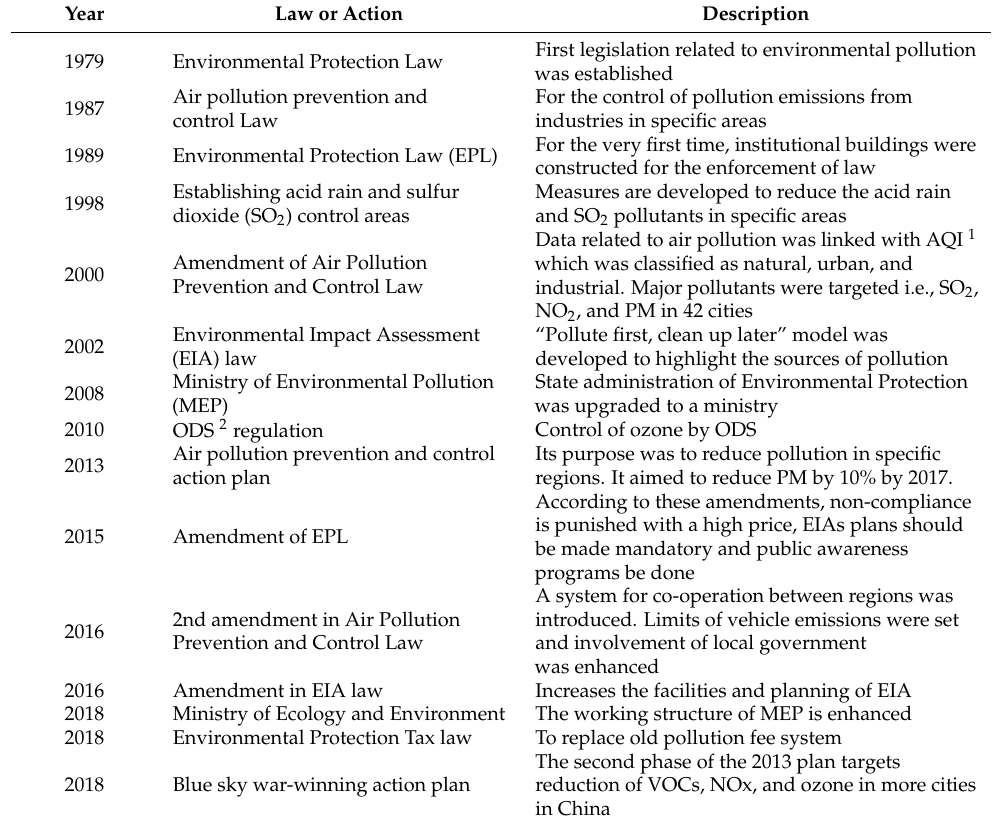
Table 2. Evolution of Chinese legislation for Air pollution control [56].